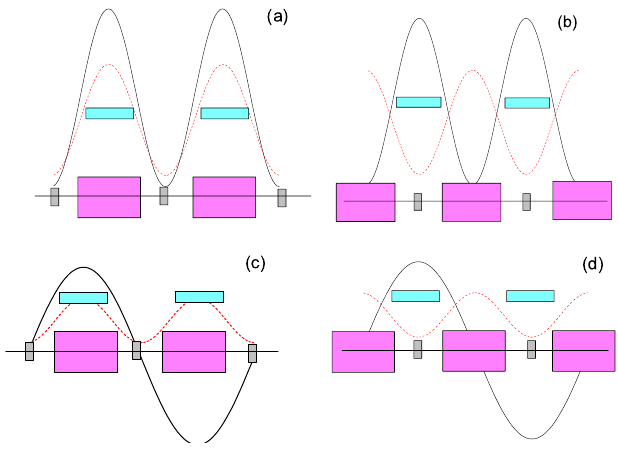
FIG. 1. (Color) The four basic lattice configurations for one coil per cell. (a) h(cid:8)j(cid:8)i , (b) h(cid:8) ^ (cid:8)(cid:8)i , (c) h(cid:8)j(cid:1)i , (d) h(cid:1) ^ (cid:8)(cid:1)i